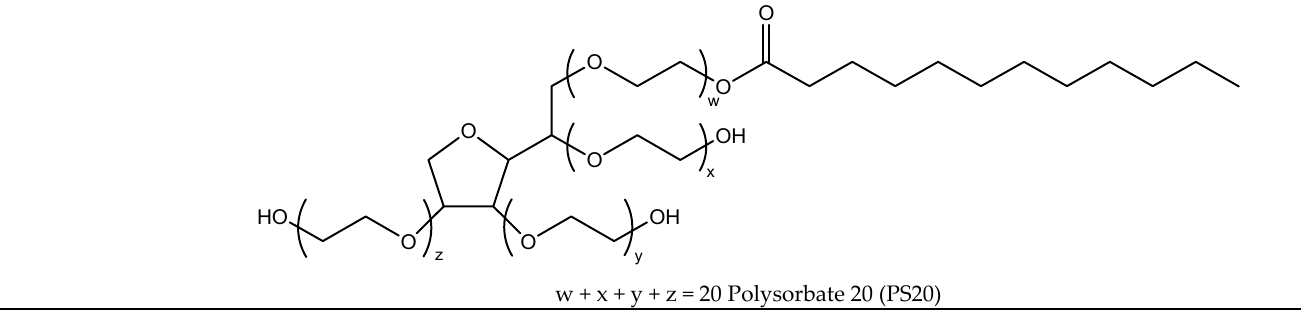
Figure 1. Molecular structures of the surfactants used in this work.